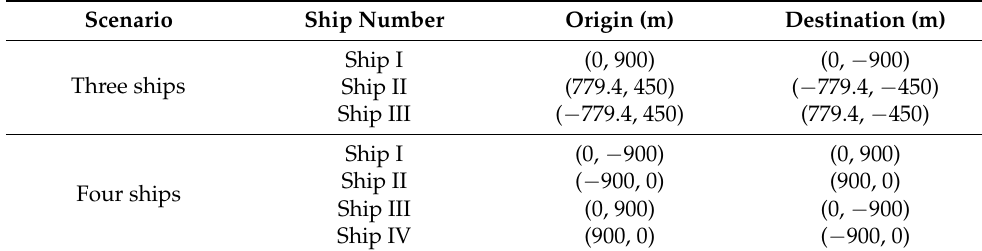
Table 5. Multi-ship scenarios parameters setup.